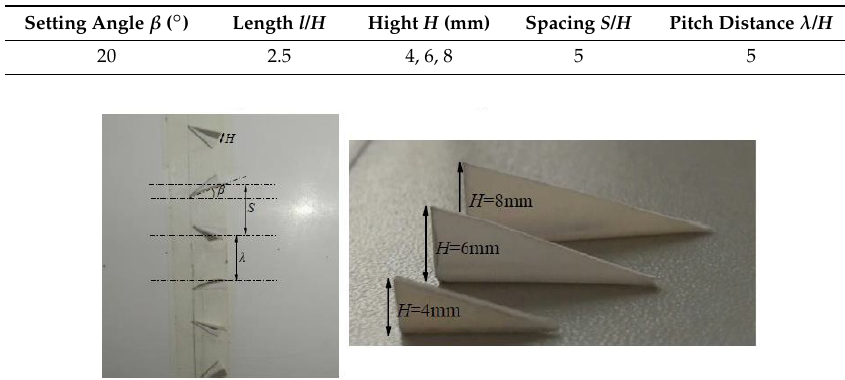
Figure 5. Test airfoil and VG geometric models.